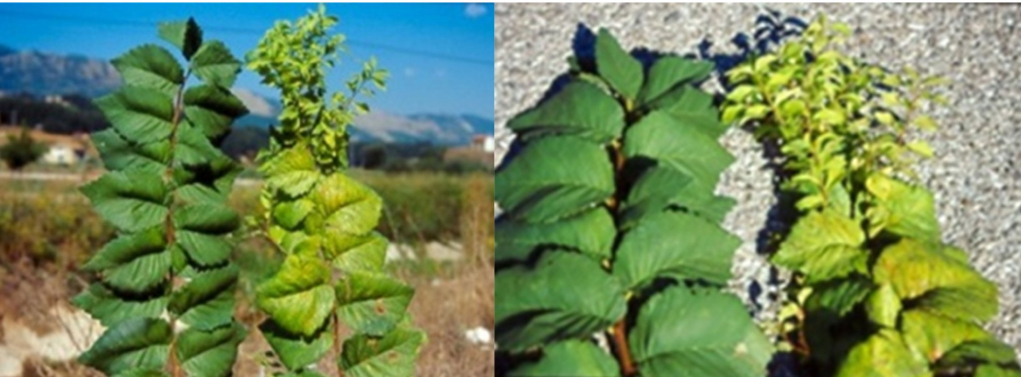
Figure 2. Small leaves, yellowing, and witches’ broom on European field elm ( Ulmus minor ) shoot affected by elm yellows disease. Left, healthy